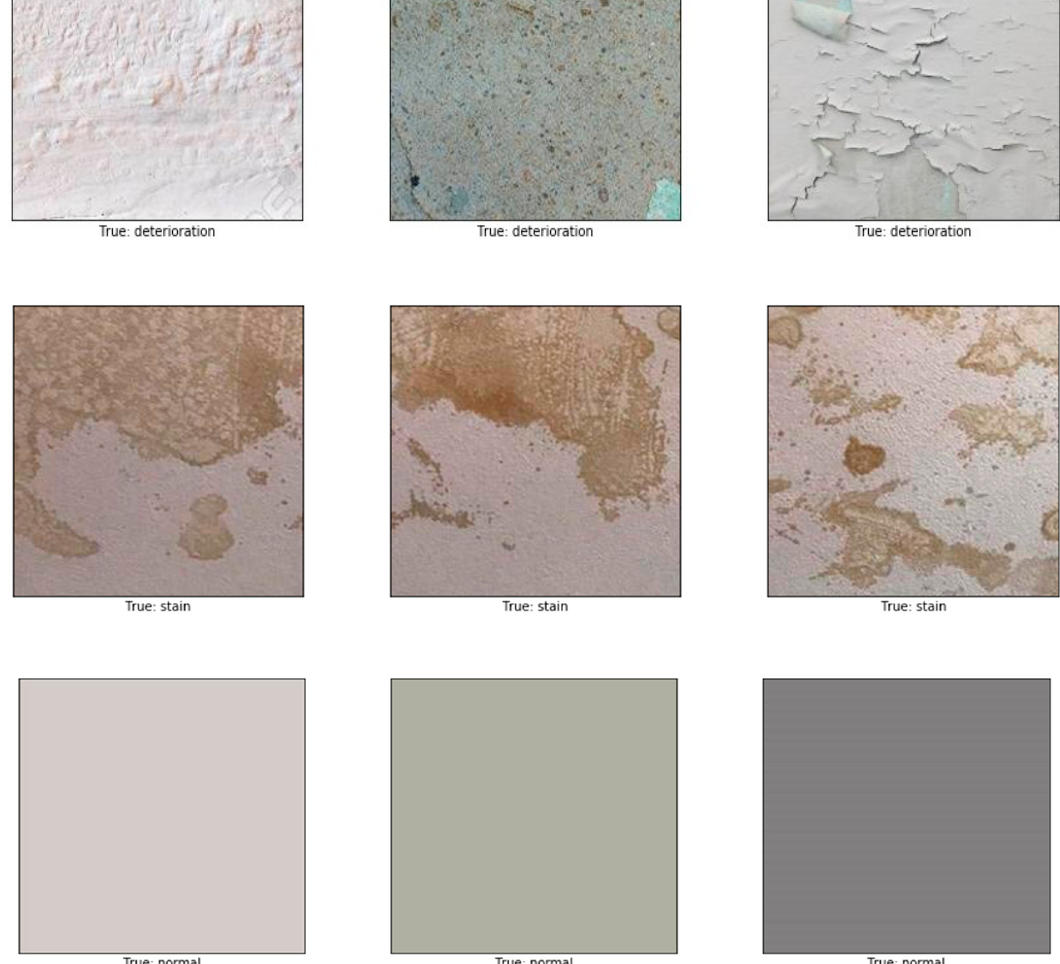
Figure 3. Dataset used in this study. A sample of the dataset that was used to train our model showing different mould images (first row), paint deterioration (second row), stains (third row).